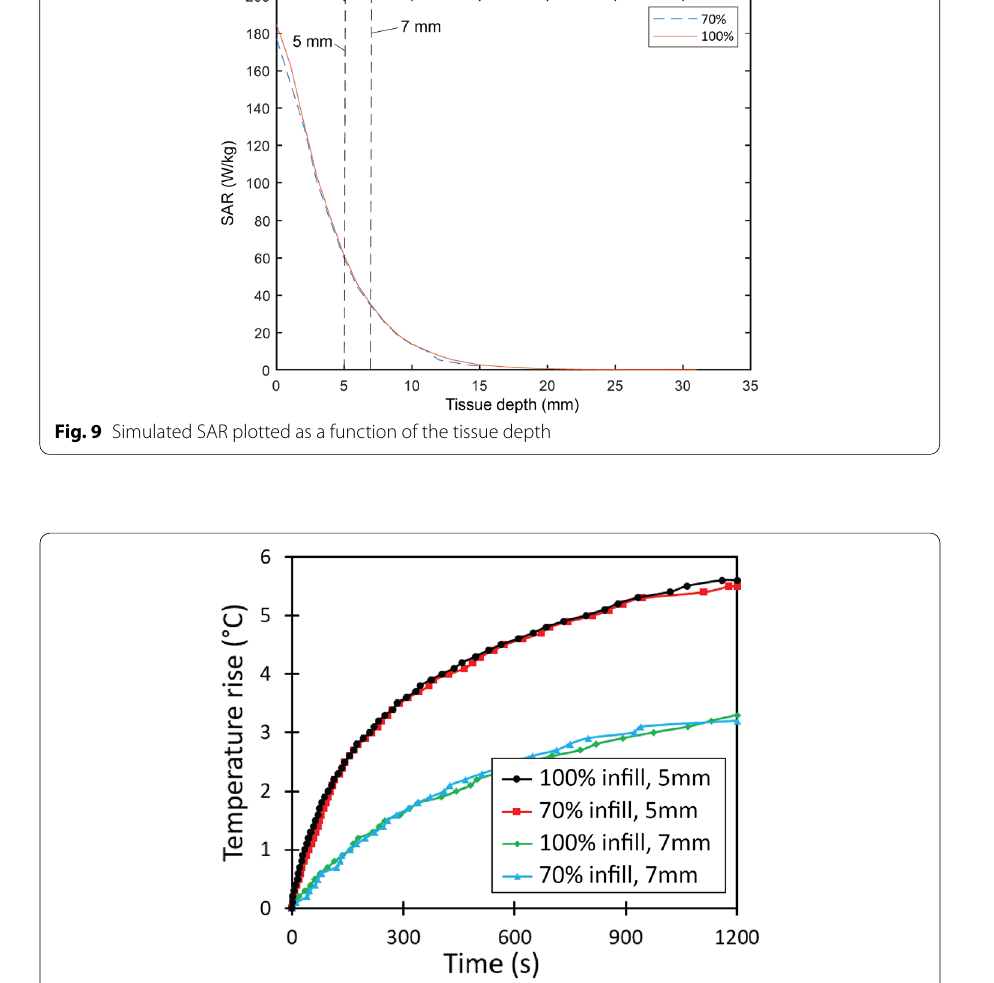
Fig. 10 Temperature rises measued at the 5 mm and 7 mm-deep locations in the breast